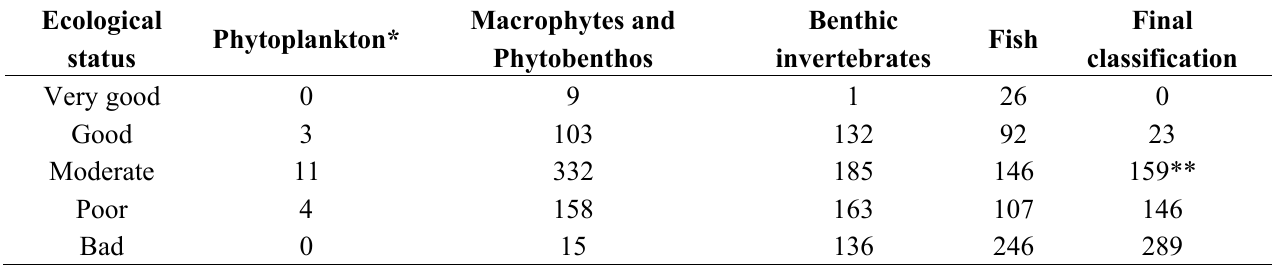
Table 4. Results of the classification of the ecological status of stream water bodies by biological quality elements (BQE) and final classification results (according to the “one-out, all-out